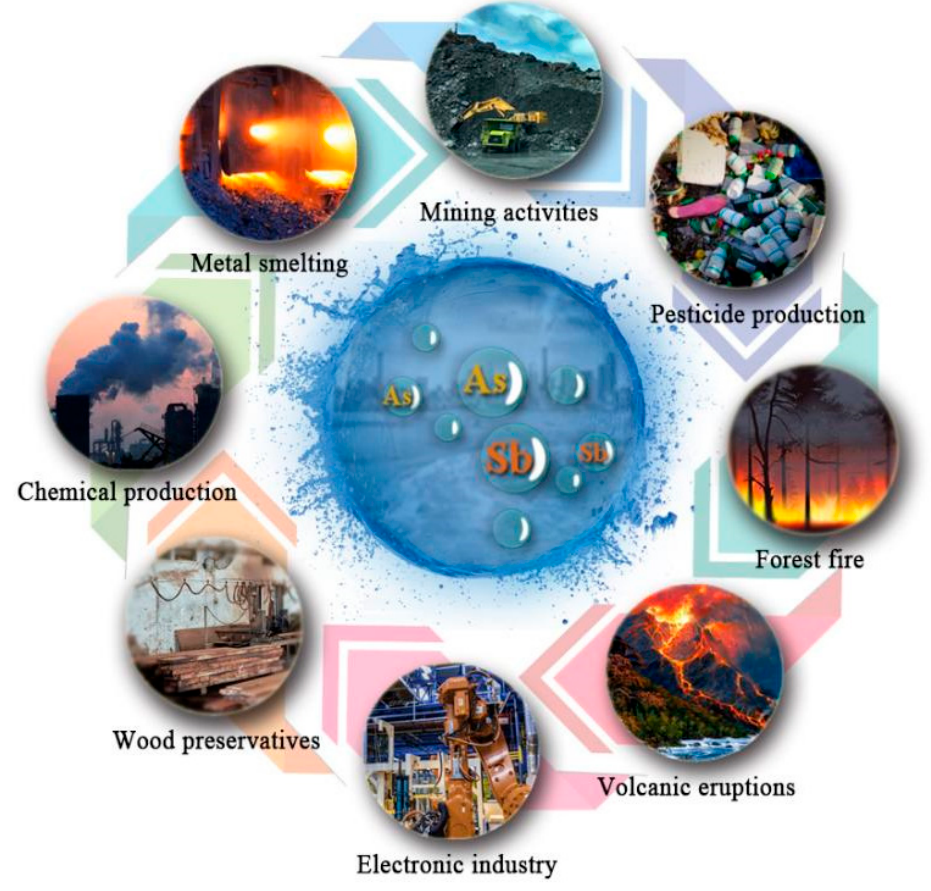
Figure 1. Sources of Sb and As pollution.